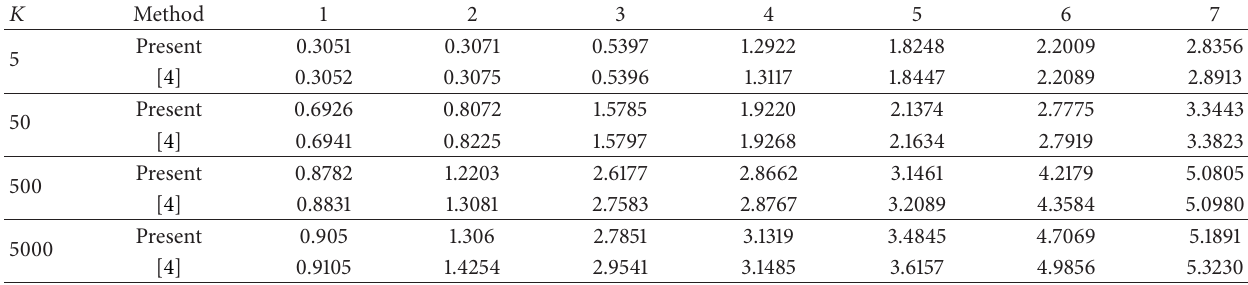
Table 6: The first seven frequency parameters Ω = ( 𝜔𝑏 2 / 𝜋 2 )( 𝜌ℎ/𝐷 ) 1/2 for Mindlin rectangular plates with two opposite free edges, the other two edges only elastically restrained against translation 𝑘 𝑥0 = 𝑘 𝑥𝑎 = 𝐾 × 𝐷 .